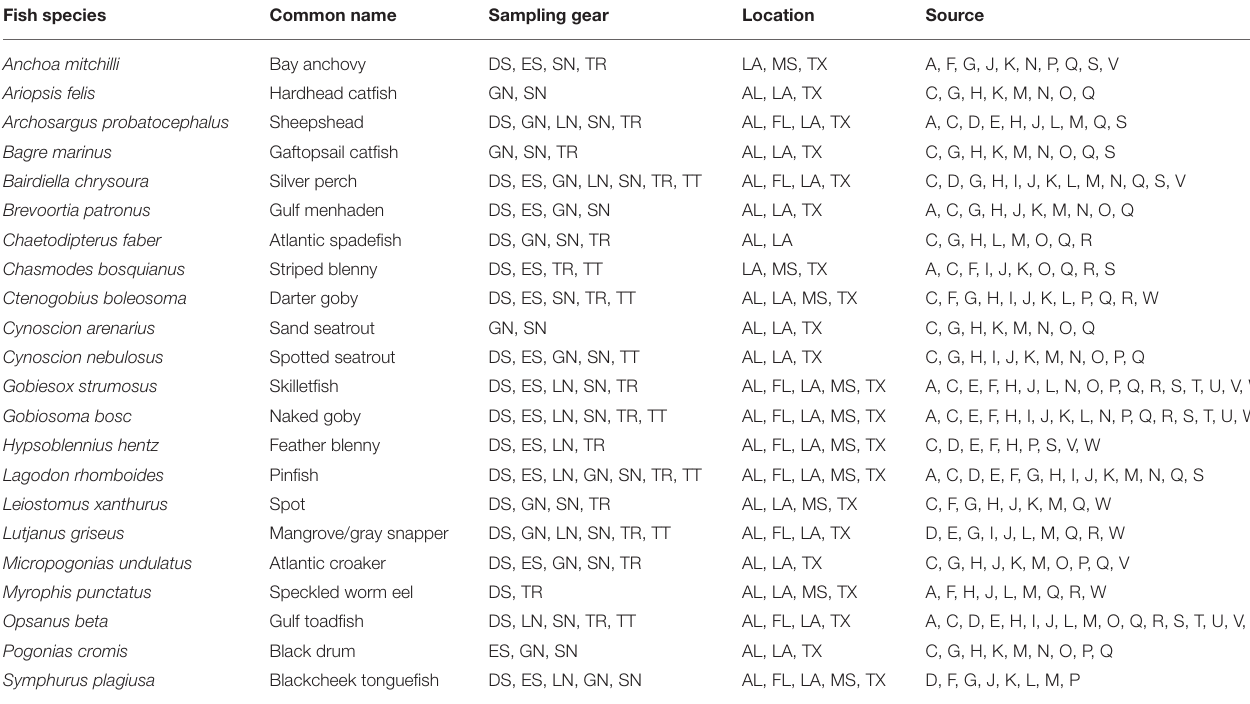
TABLE 3 | List of fish species reported in 8 studies or more, with sampling gear, location, and source.